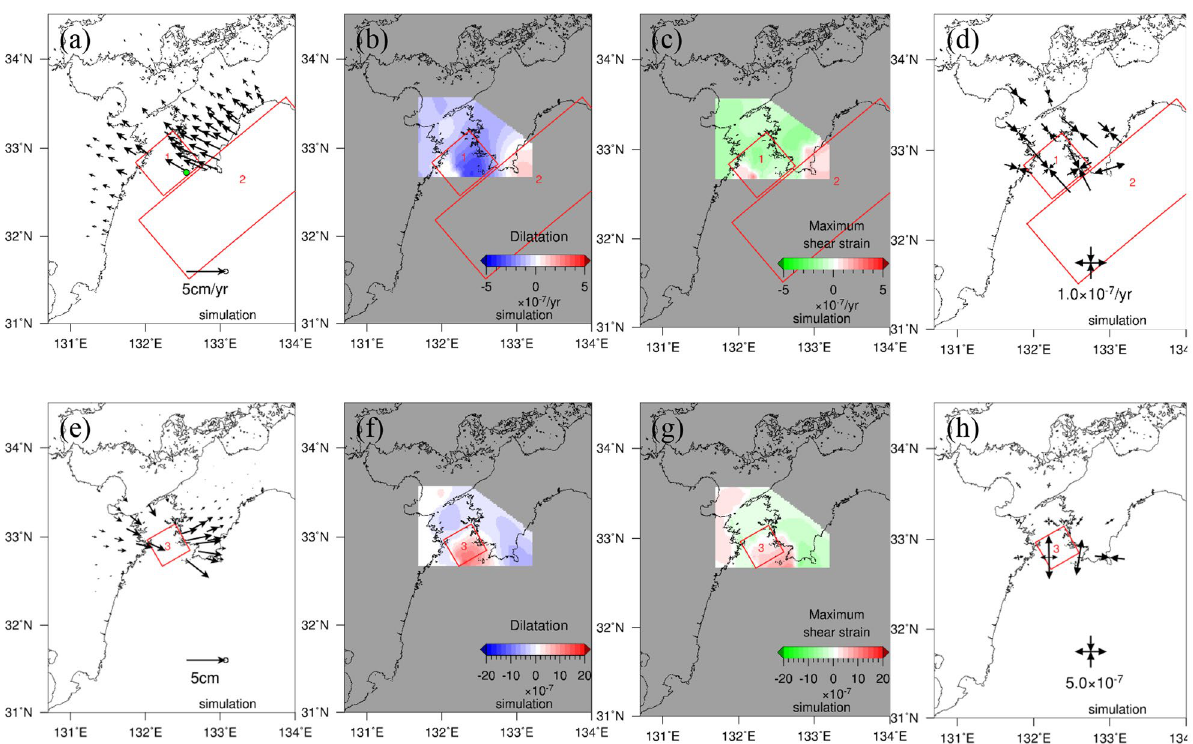
Figure 6. Displacement and various strain fields at the Earth’s surface calculated using the rectangular fault model beneath the Bungo Channel and its shallower plate interface. Red rectangles 1 to 3 represent the horizontal projections of the assumed fault planes (see Table 2). The green dot in ( a ) is the Sukumo station (021059), which is the closest to the Bungo Channel. The map was created by using the Generic Mapping Tools (GMT) 27 (version: GMT3.4.6, URL link: https:// www. gener ic- mappi ng- tools. org/ downl oad/).